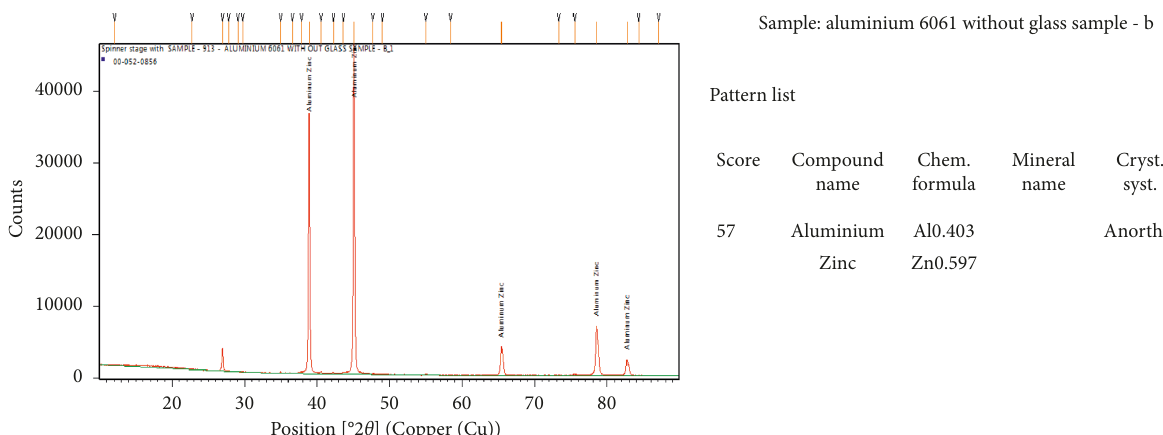
Figure 7: X-ray diffraction analysis pattern of 5% of reinforcement without glass fibre.